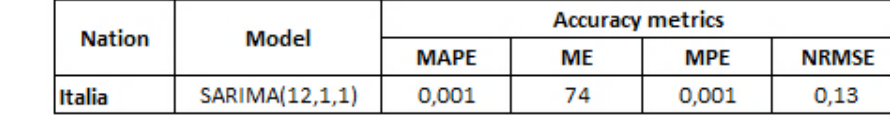
Figure 14. Comparison of the test with the prediction Table 3. Accuracy metrics of the SARIMA (12,1,1) model